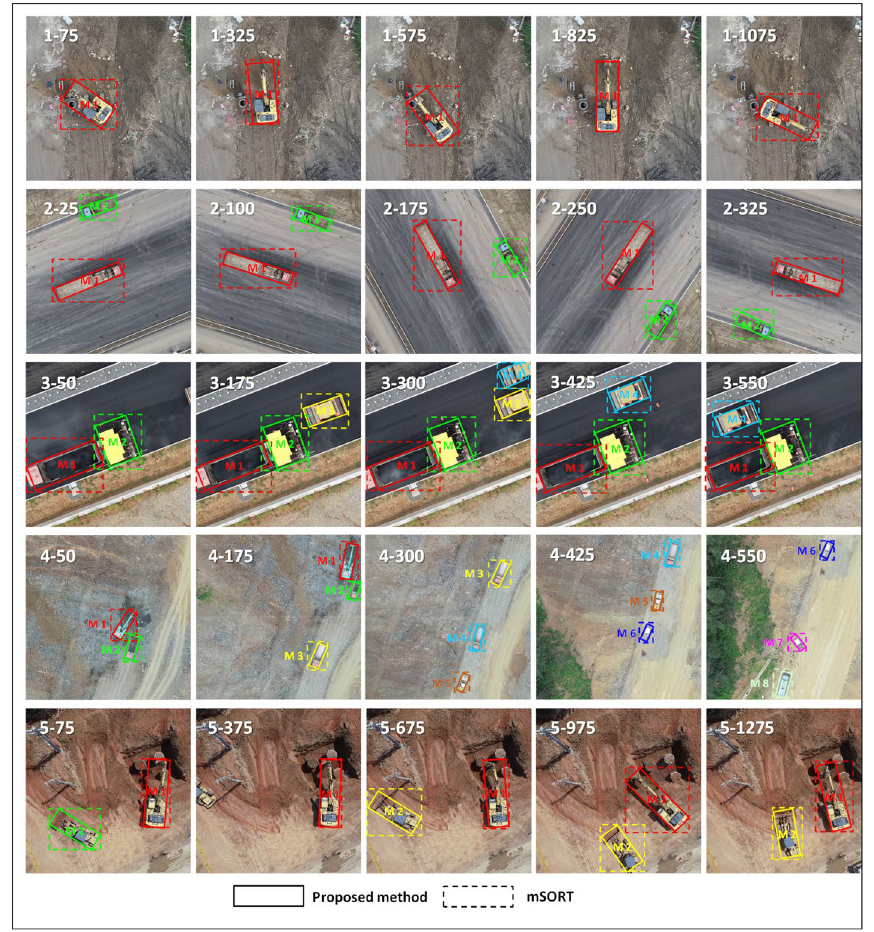
Fig. 4 Tracking results comparison between the proposed method and mSORT